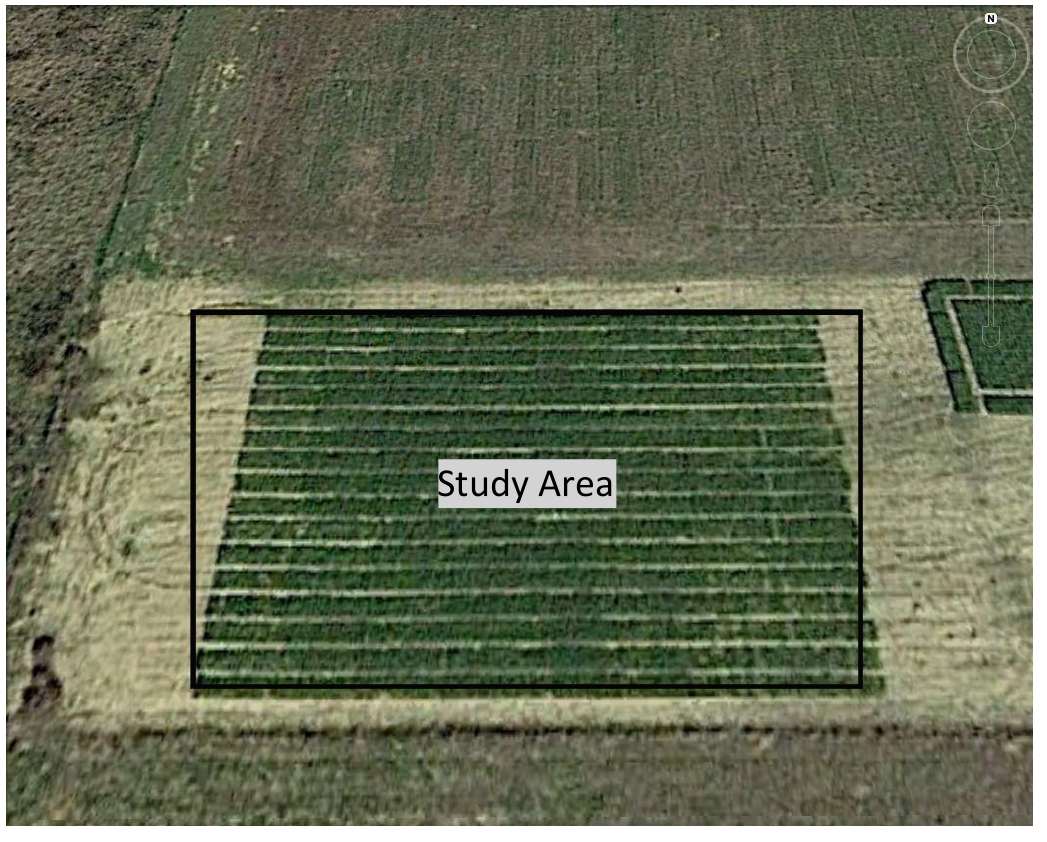
Figure 4. Aerial imagery of the unit 3 wheat